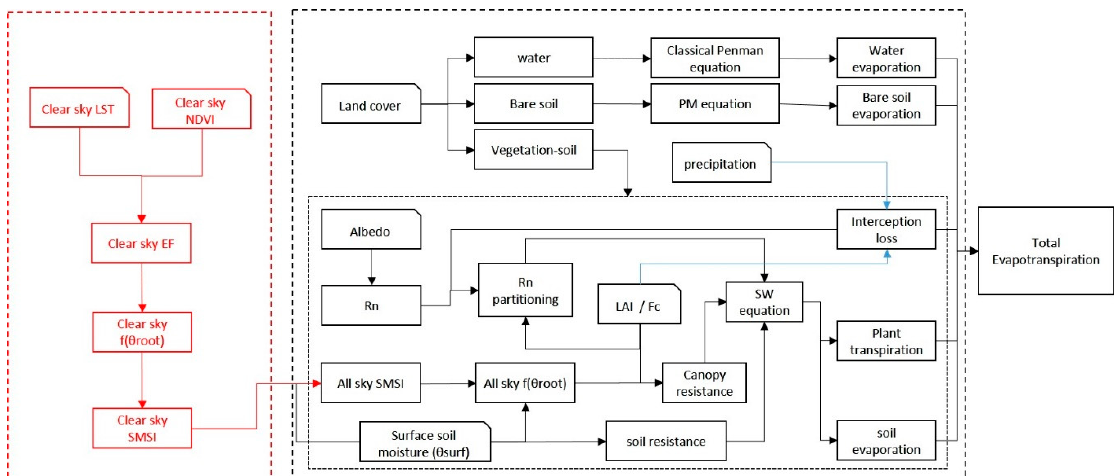
Figure 1. ET estimation flowchart in current study. The left block stands for the land surface temperature (LST)-based method to parameterize the regulation of soil moisture on the ET, while the right block illustrates the interpolation to the cloudy days and the estimation of daily ET.